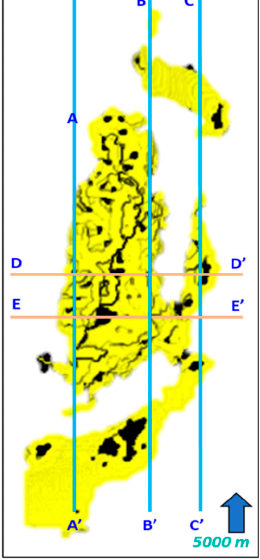
Figure 7. Overview of training dataset from SEAM Phase I illustrating five (5) cross-sections (A–A’), (B–B’), (C–C’), (D–D’) and (E–E’) cutting across SEAM Reservoir Model. Blue lines represent inline sections, and the remaining lines represents the crosslines.